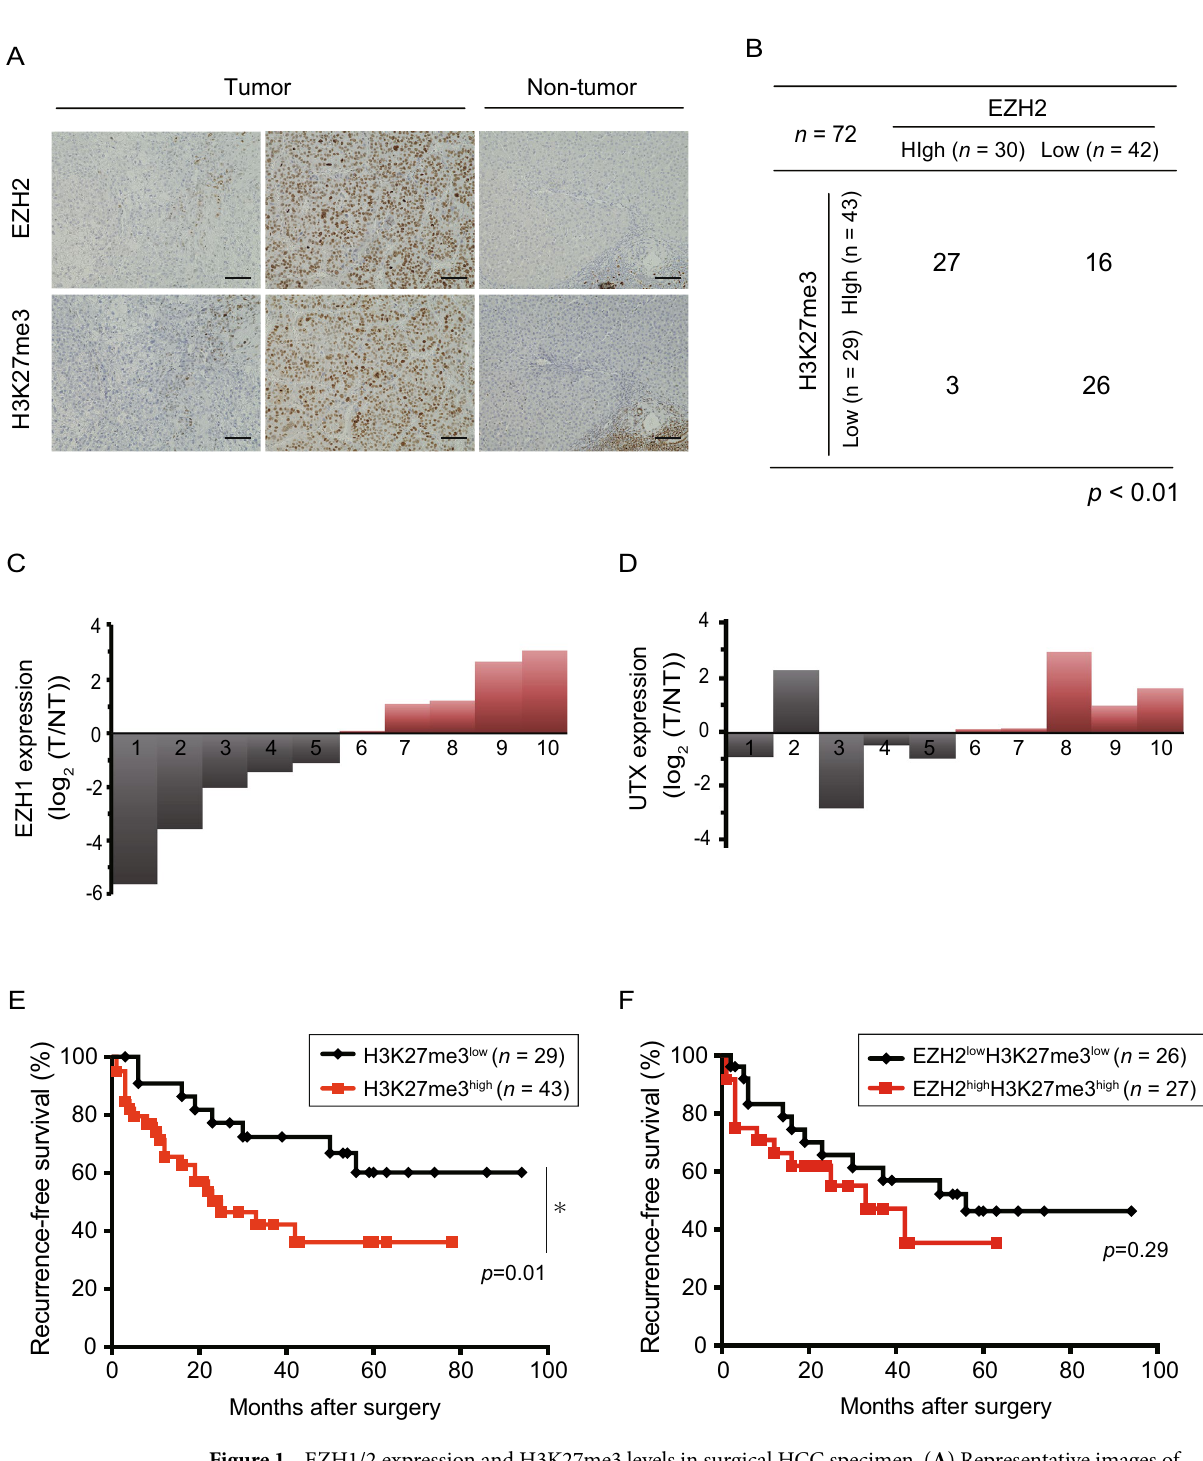
Figure 1. EZH1/2 expression and H3K27me3 levels in surgical HCC specimen. ( A ) Representative images of immunohistochemistry staining for EZH2 and H3K27me3 tumors and tumor-free tissues. Scale bar = 100 µm. ( B ) Relationship between EZH2 expression and H3K27me3 levels in HCC tissues (Fisher’s exact test, p < 0.01). ( C ) Waterfall plots showing EZH1 mRNA expression in EZH2 low H3K27me3 high HCCs. ( D ) Waterfall plots showing UTX mRNA expression in EZH2 low H3K27me3 high HCCs. ( E ) Cumulative recurrence-free survival based on H3K27me3 levels (log-rank test, * p < 0.05). ( F ) Cumulative recurrence-free survival between EZH2 low H3K27me3 low and EZH2 high H3K27me3 high patients (log-rank test, * p <